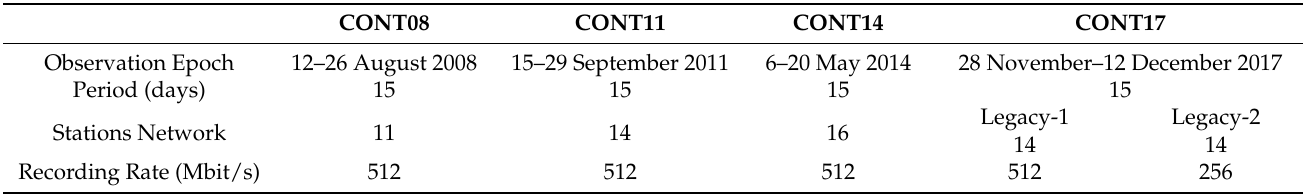
Table 2. Statistics of stations participating in CONT